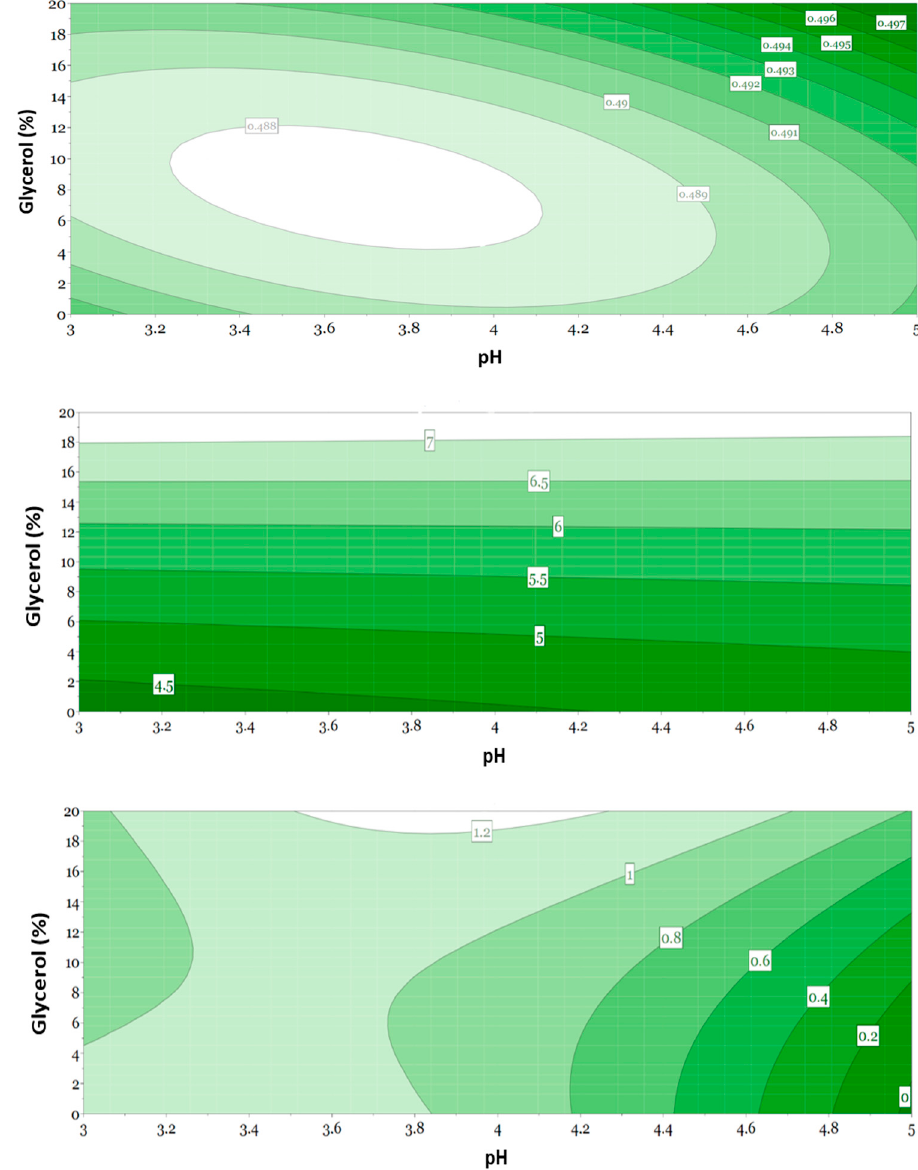
Figure 5. Response contour plot for responses dosing accuracy (dispensed dose) ( top figure ), vis- cosity ( middle figure ) and solubility ( bottom figure ) as a function of amount of glycerol and pH. Compositions of formulations N1–N12 according to Table 5, containing propranolol. The target dose was 0.5 mL, corresponding to 5 mg propranolol. ± 10% of the target dose was considered an acceptable dosing accuracy. Values above 1 in the solubility plot indicate that propranolol is soluble in the formulation, values below 1 indicate that propranolol is not soluble.